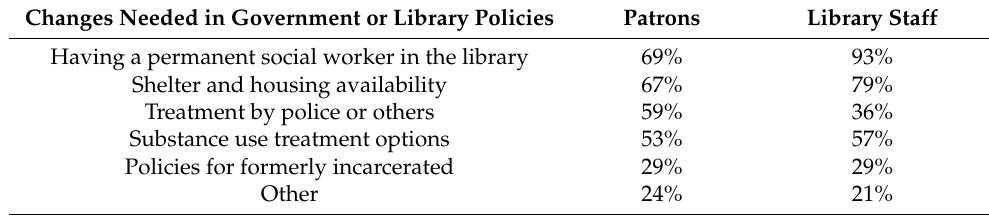
Table 4. Perceived Changes Needed in Government or Library Policies ( n = 63; 49 Patrons, 14 Library